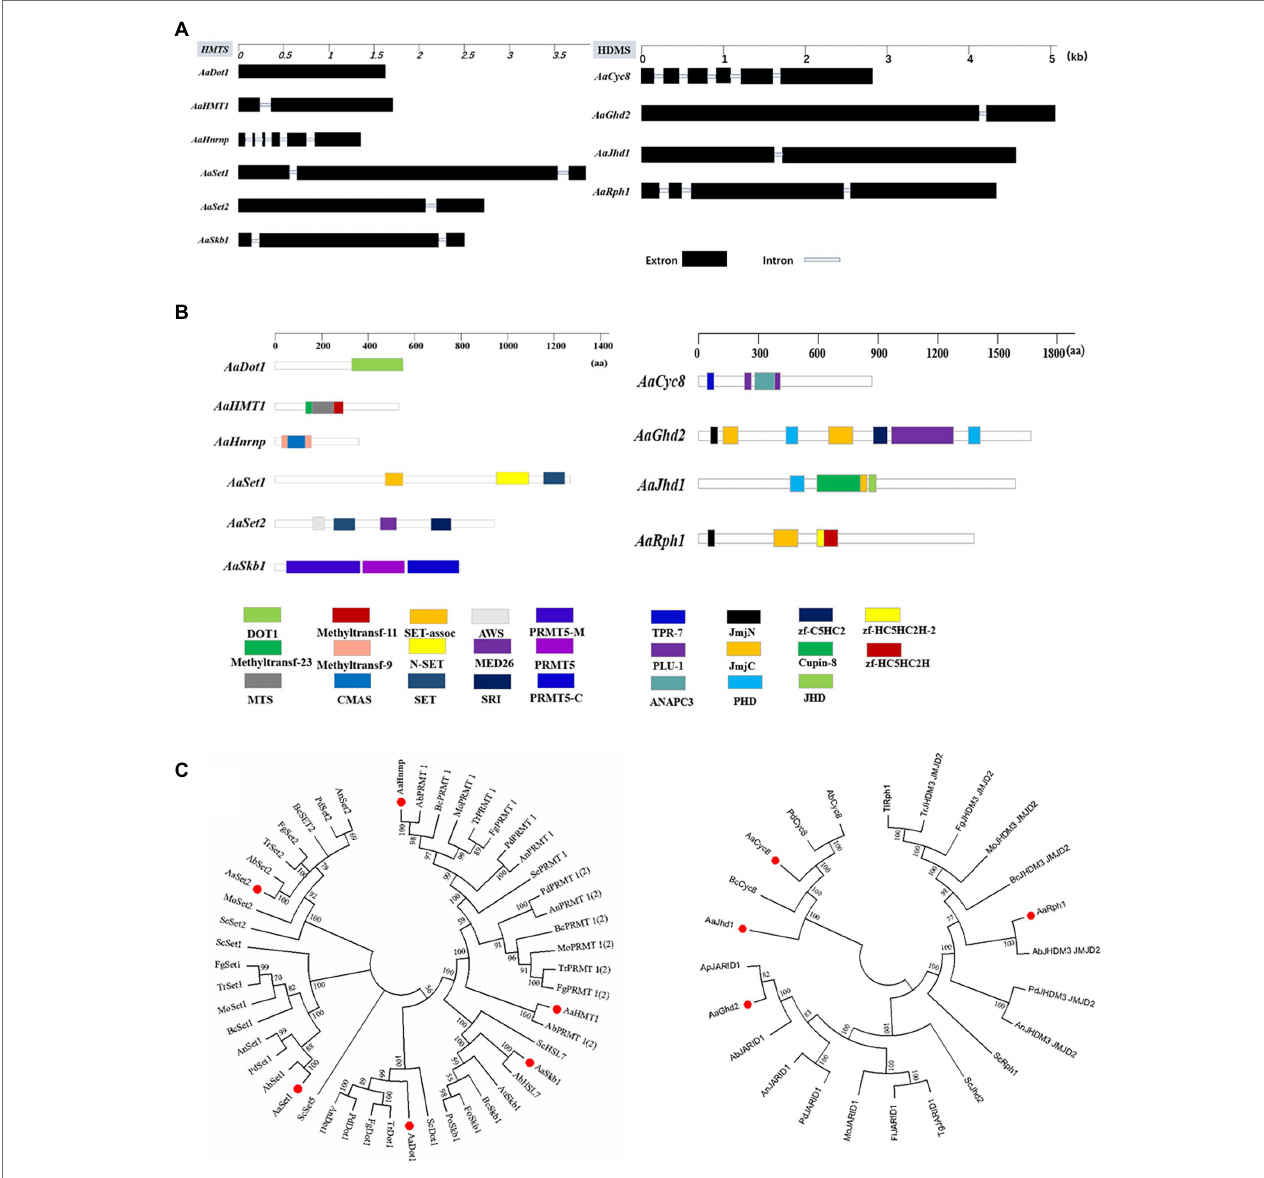
FIGURE 1 | Identification and phylogenetic analysis of HMTs and HDMs in A. alternata. (A) Schematic depiction of the gene structure of HMTs and HDMs. (B) Schematic depiction of conserved protein domains of HMTs and HDMs. (C) Phylogenetic trees were constructed using the neighbor-joining algorithm of MEGA7. (Aa: A. alternata ; Ab (left): A. brassicicola ; Bc: B. cinerea ; Mo: M. oryzae ; Tr: T. reesei ; Fg: F. graminearum ; Pd: P. digitatum ; An: A. nidulans ; Fo: F. oxysporum ; Au: A. udagawae ; Ap: A. panax ; Tg: T. gamsii ; Fl: F. longipes ; Tl: T. lentiforme ; Ab (right): A. bombycis